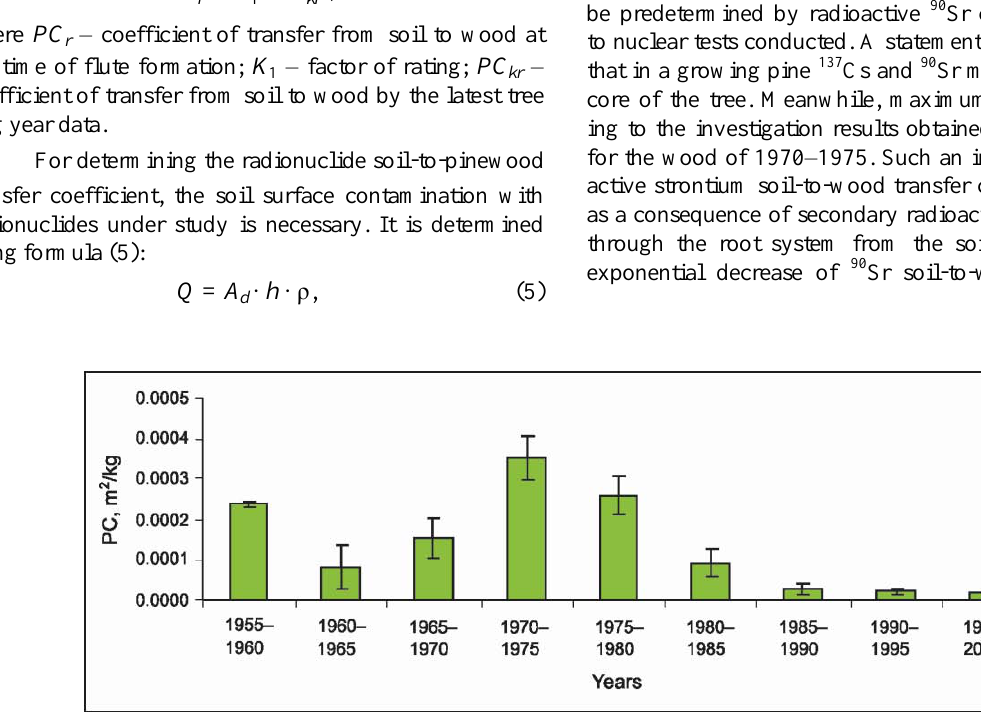
Fig. 2. Fluctuation of 90 Sr transfer coefficient from soil to pinewood (1 m from